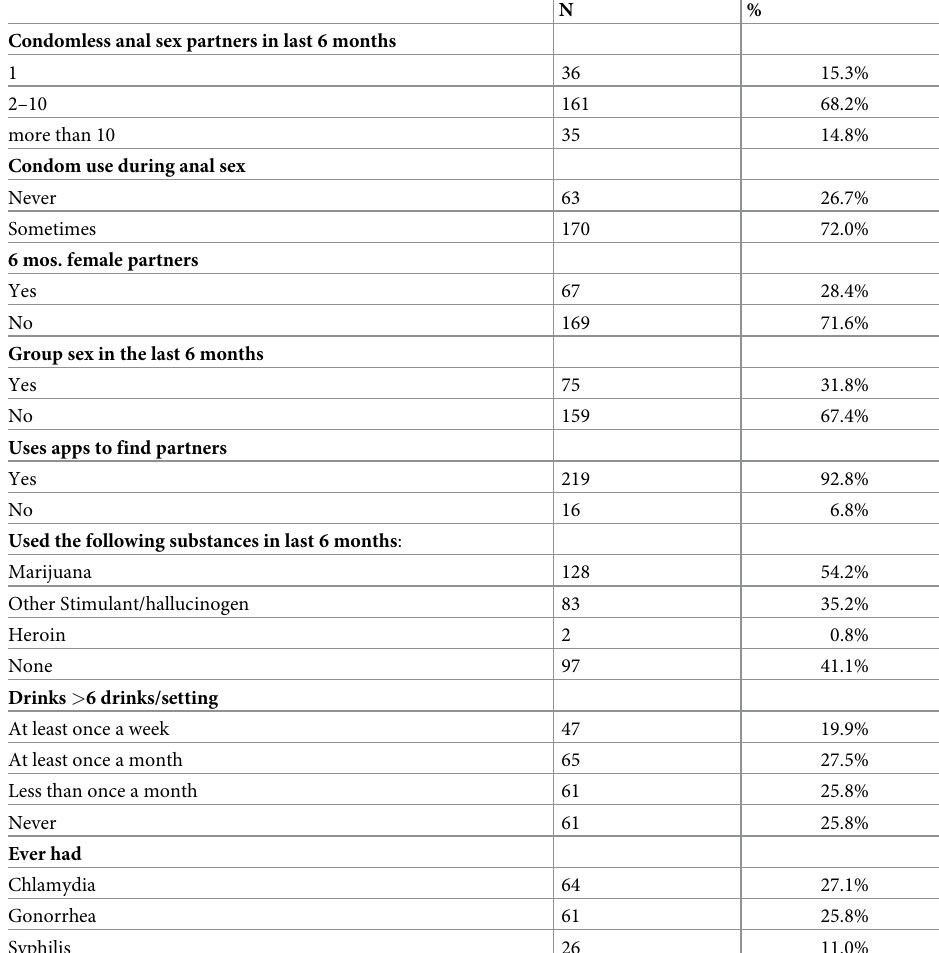
Table 3. HIV risks of 236 PrEP eligible young men who have sex with men from an online survey in the U.S.